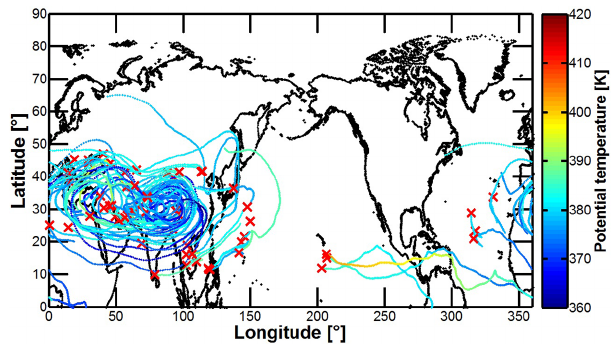
Figure 7. Pathway of the trajectory ensemble as shown in Fig. 6 with PV Tra < 5pvu. Red crosses mark the location of the trajecto- ries where PV values exceed 5pvu.